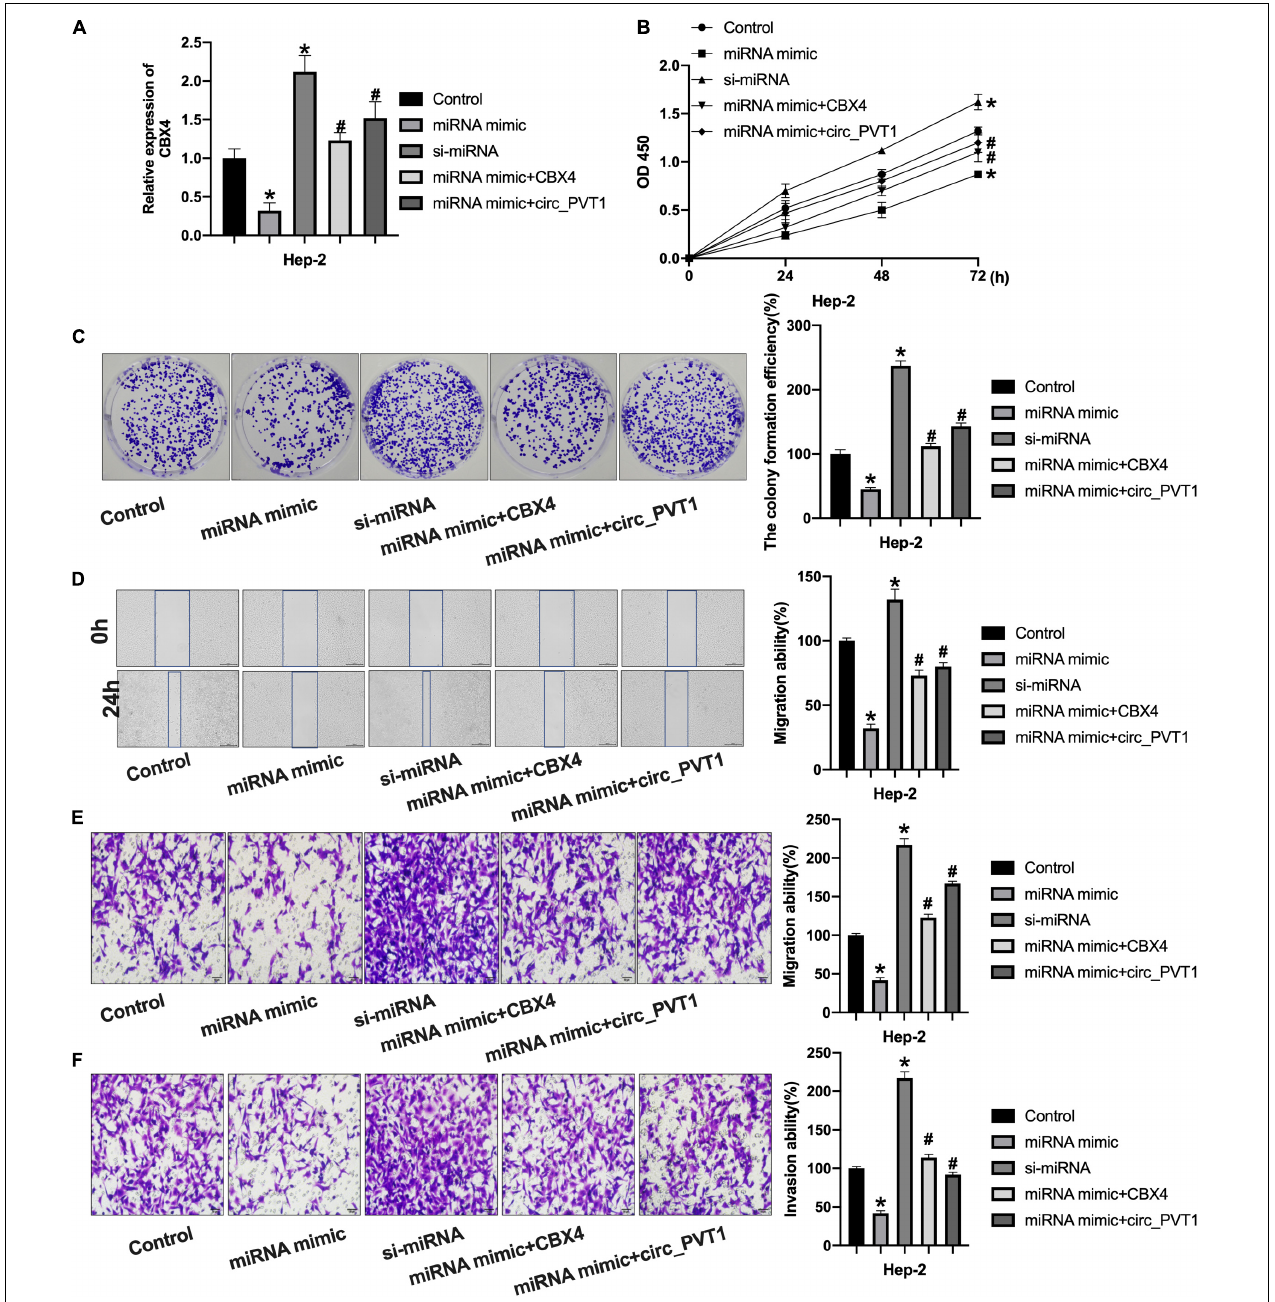
FIGURE 6 | Circ_PVT1 regulated LC cells progression via targeting miR-21-5p/CBX4 signal pathway. (A) The level of CBX4 was detected by qRT-PCR. * P < 0.05 vs. Control, # P < 0.05 vs. miR-21-5p. n = 4. (B) The CCK-8 assay was performed in Hep-2 cells. * P < 0.05 vs. Control, # P < 0.05 vs. miR-21-5p. n = 4. (C) The clone formation assay was performed in Hep-2 cells. * P < 0.05 vs. Control, # P < 0.05 vs. miR-21-5p. n = 4. (D) Wound healing assay was performed in Hep-2 cells. * P < 0.05 vs. Control, # P < 0.05 vs. miR-21-5p. n = 4. (E,F) Transwell migration and invasion assay was performed in Hep-2 cells. * P < 0.05 vs. Control, # P < 0.05 vs. miR-21-5p. n =